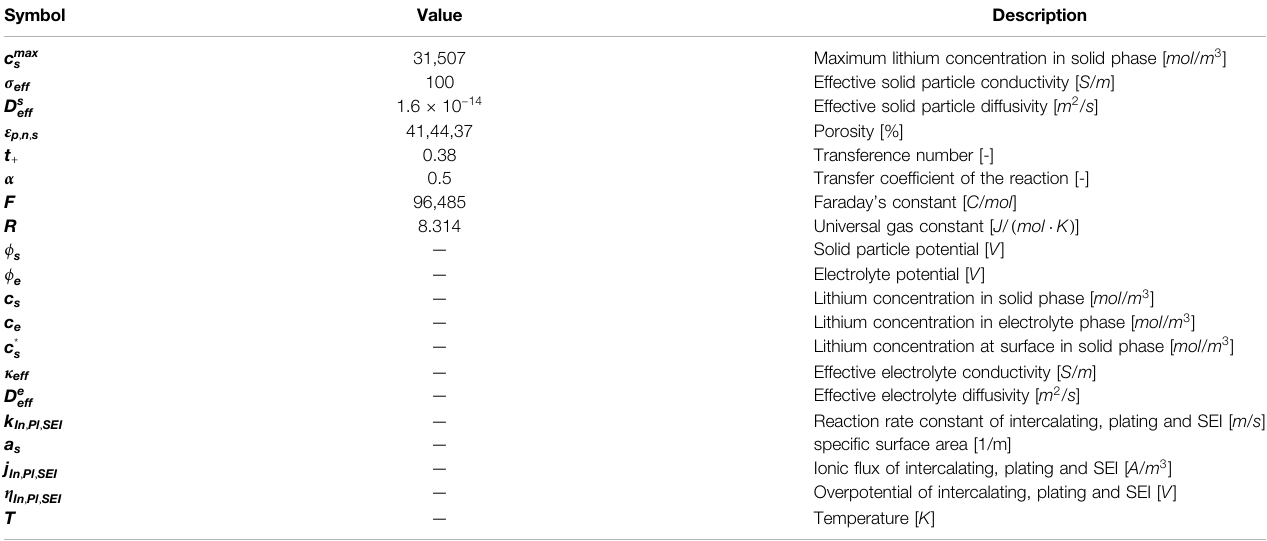
TABLE 1 | Symbols and descriptions of the P2D model